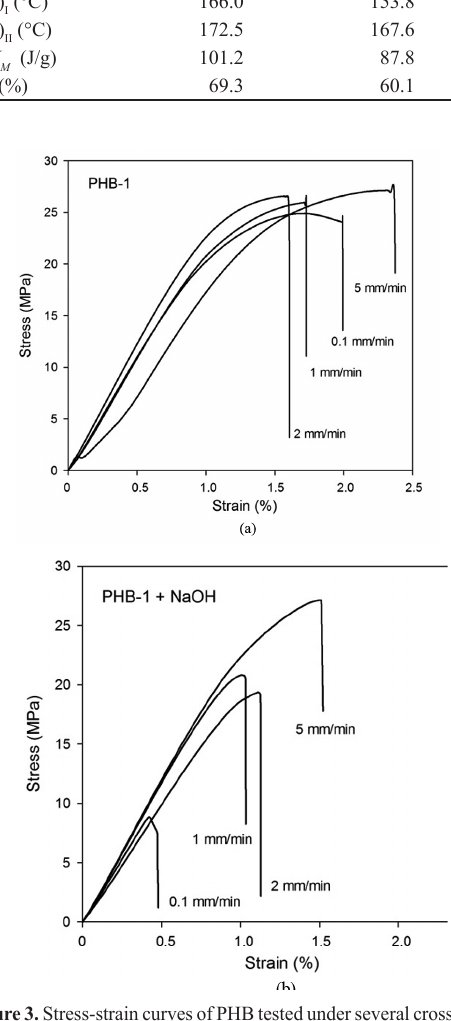
Figure 3. Stress-strain curves of PHB tested under several crosshead speeds (indicated) with specimens unexposed (a) and exposed (b) to the alkaline